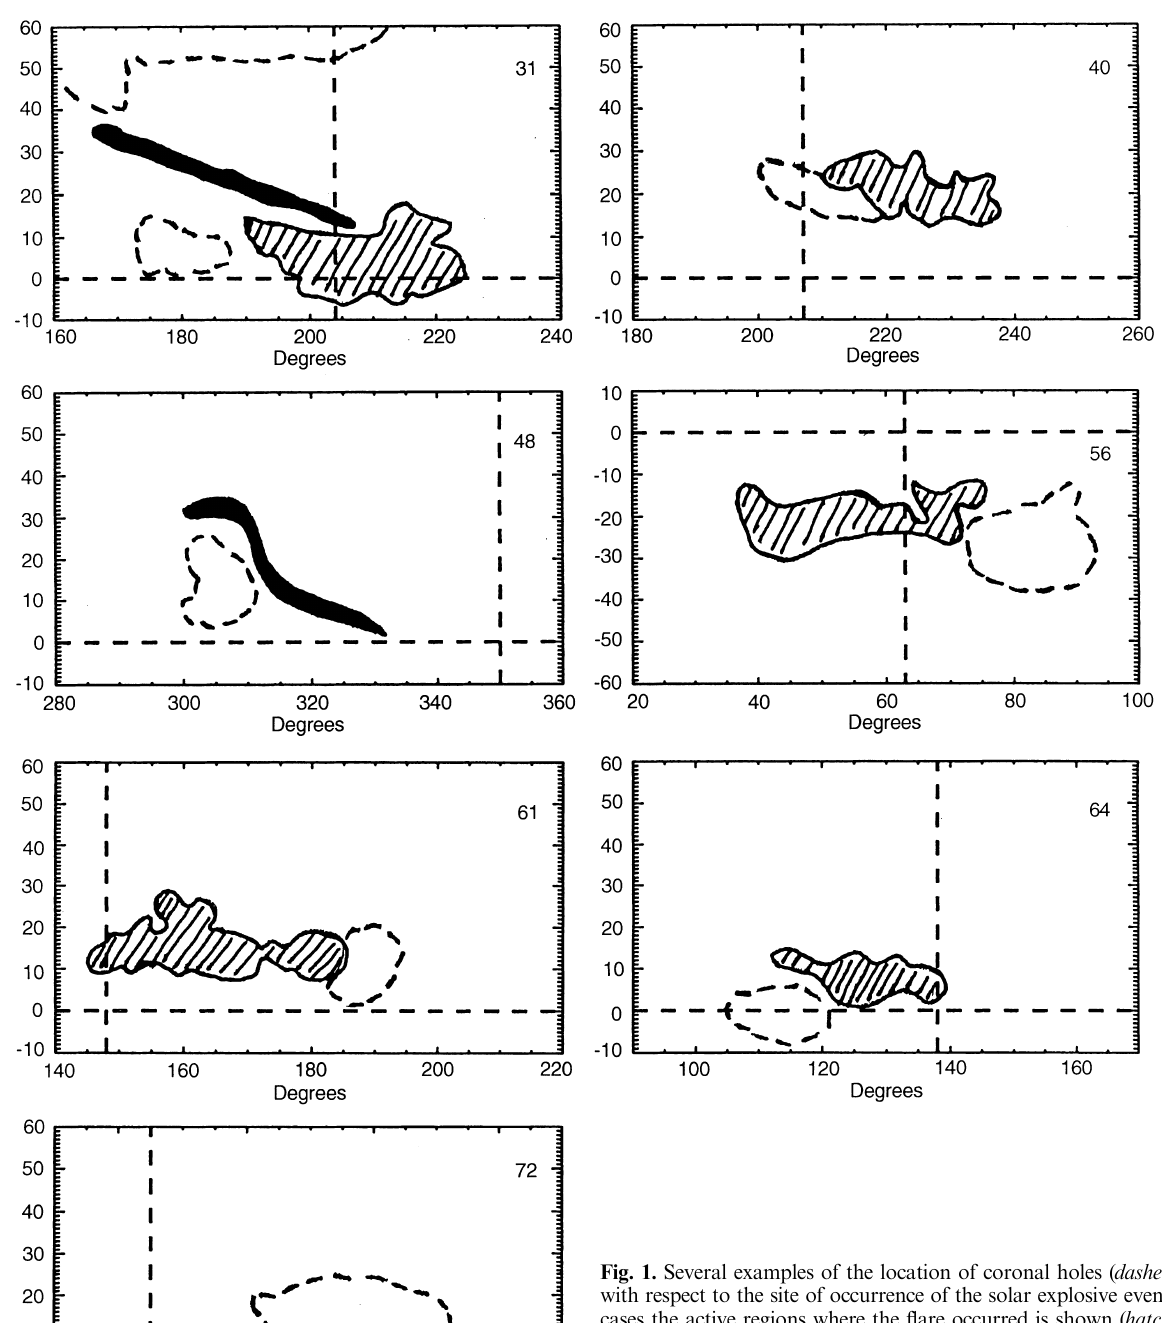
Fig. 1. Several examples of the location of coronal holes ( dashed contours ) with respect to the site of occurrence of the solar explosive event. In the flare cases the active regions where the flare occurred is shown ( hatched regions ), and in the cases of filament eruptions the filament is also drawn. The position of the solar central meridian at the time of the event is indicated with a vertical broken line . The number at the top right corner indicates the number of